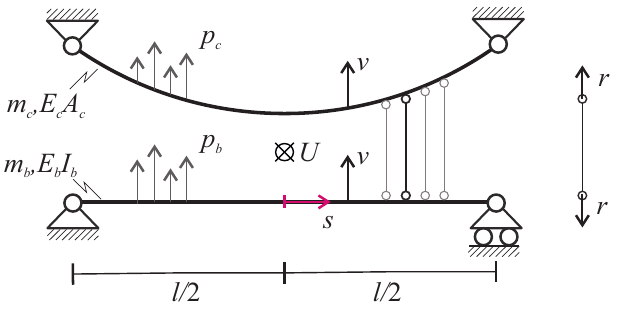
Figure 1. Single-span suspension bridge